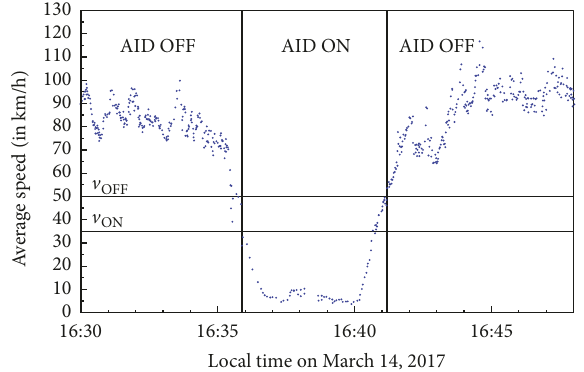
Figure 1: AID switching. The AID switches on and off based on the average speed of the loop sensor. The blue dots show the average of all samples across all lanes. The AID goes on when the average drops beneath the V ON threshold just before 16:36 and goes off when traffic restores after